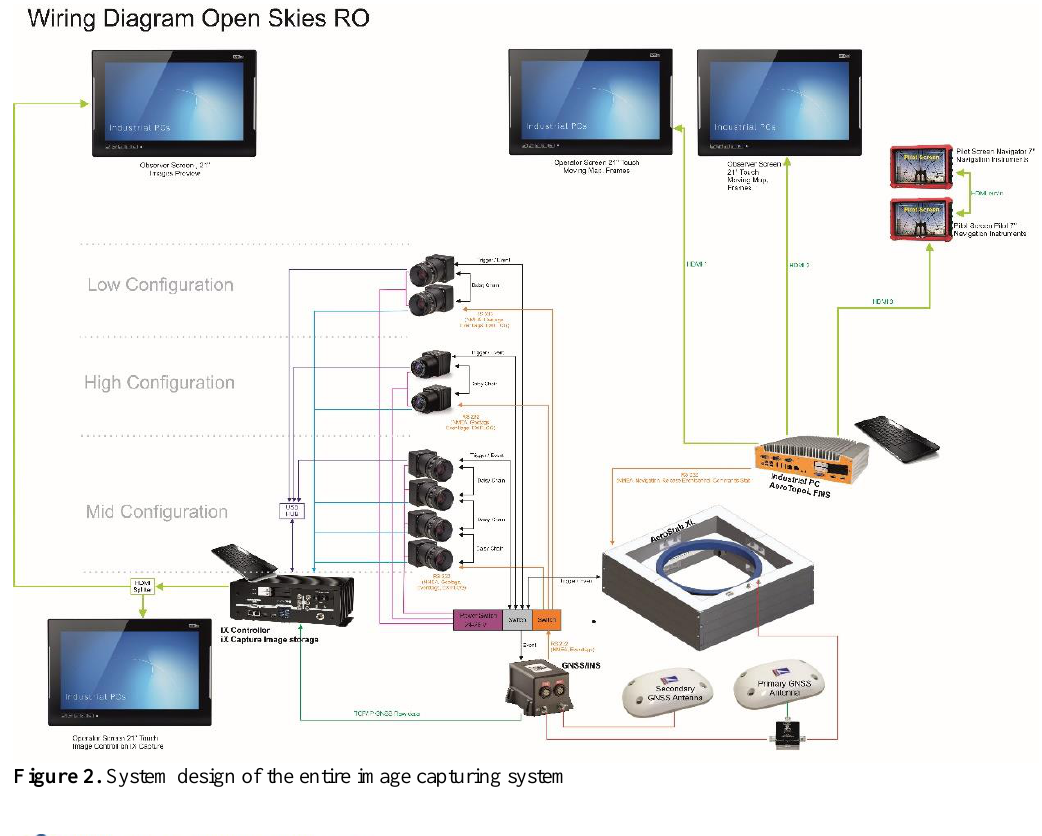
Figure 2. System design of the entire image capturing system